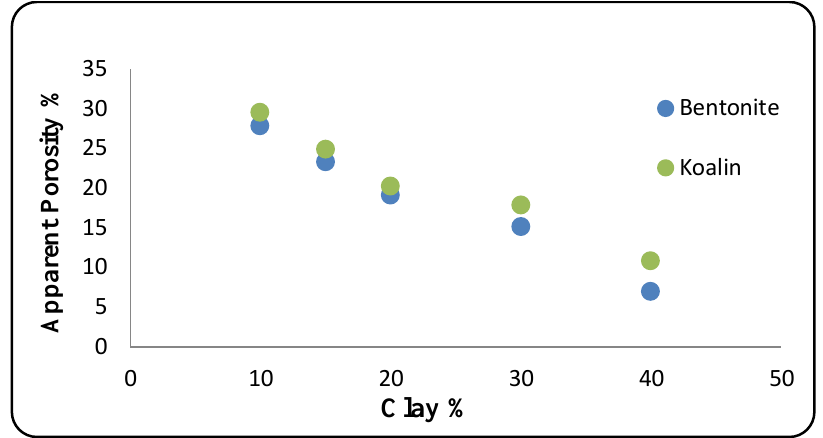
Figure 3: Apparent porosity for K-mortar and